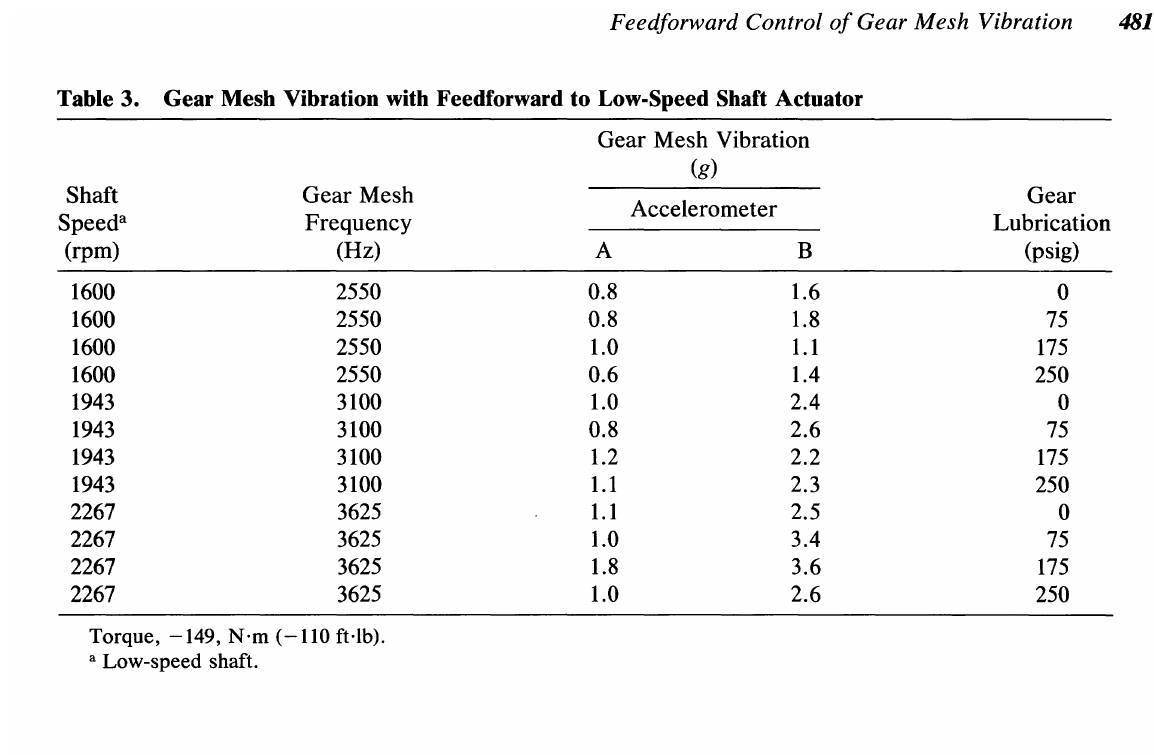
Table 3. Gear Mesh Vibration with Feedforward to Low-Speed Shaft